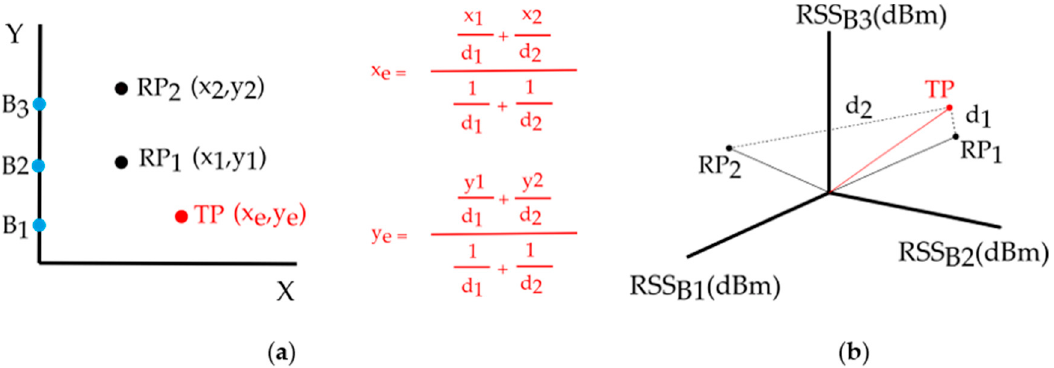
Figure 4. Example of application of the weighted k-nearest neighbor (WKNN) algorithm for two reference points, RP 1 and RP 2 , one test point, TP, and three beacons, B 1 , B 2 and B 3 : ( a ) Calculation of the estimated coordinates ( x e , y e ) as a weighted average of the coordinates of k-nearest RPs ( k = 2) with the shortest distance to the TP in the signal space; ( b ) Euclidean distances of the RPs to the TP in the signal space.